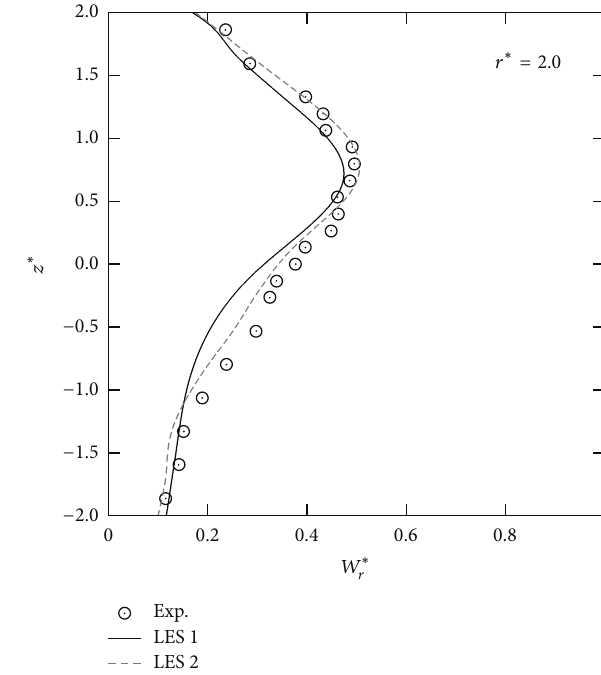
Figure 8: Radial component of the ensemble-averaged mean veloc- ity at 𝑟 ∗ = 1.6 .